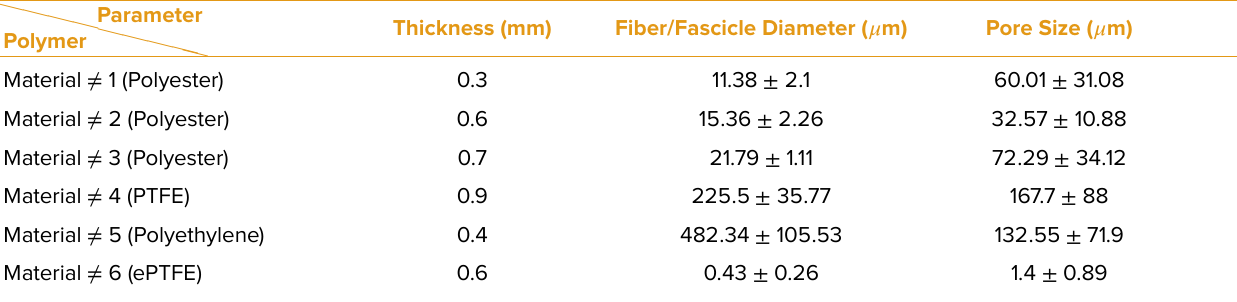
Table 1. Physical characteristics of the examined